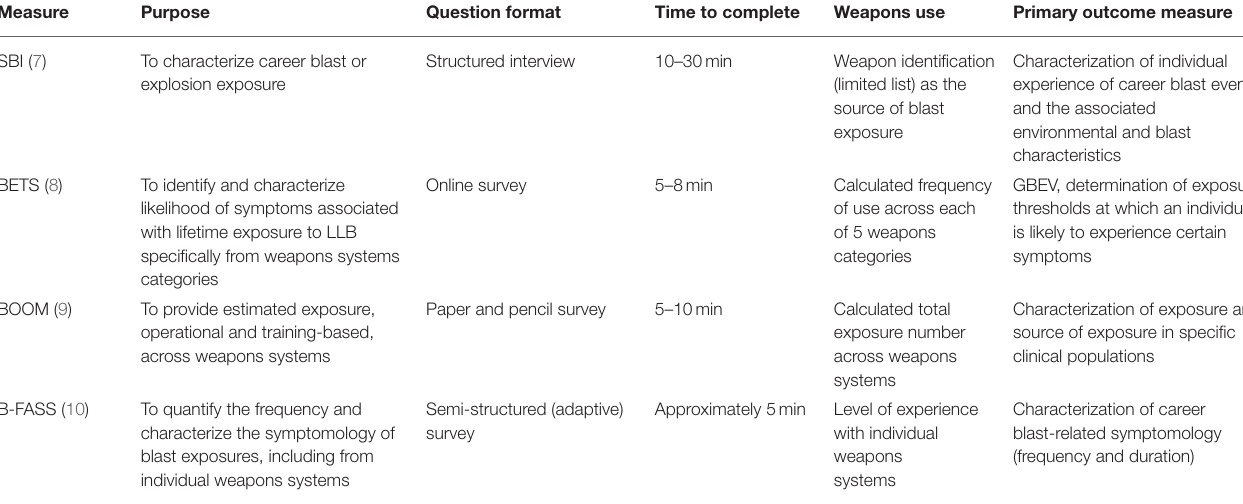
TABLE 1 | Summary of measures utilized to capture career